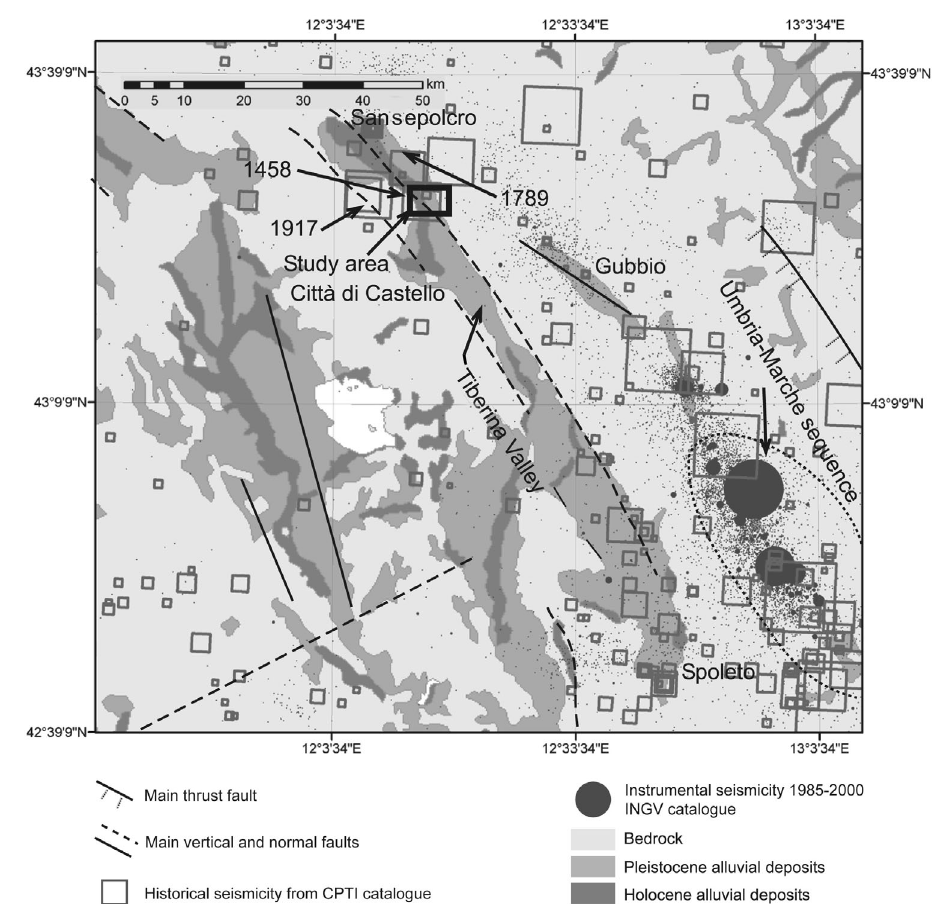
Fig. 1. Simplified geological and structural map of the investigated area. Historical and instrumental seismici- ty is also